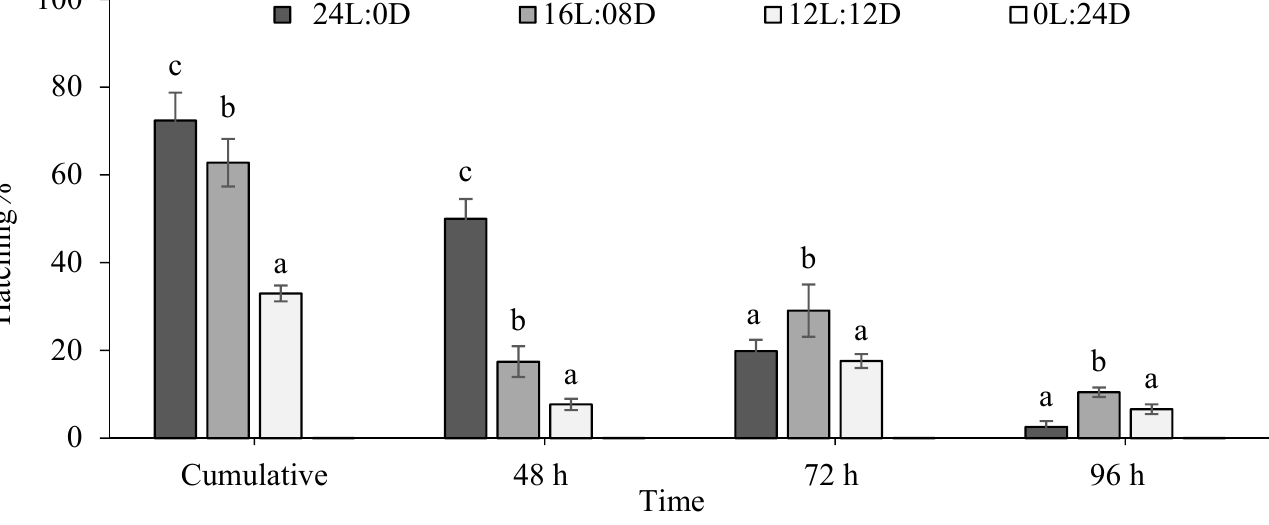
Table 2. Total length (TL), daily growth, specific growth rate (SGR), and final body weight of B. orientalis under different photoperiods (mean ± SD, n =